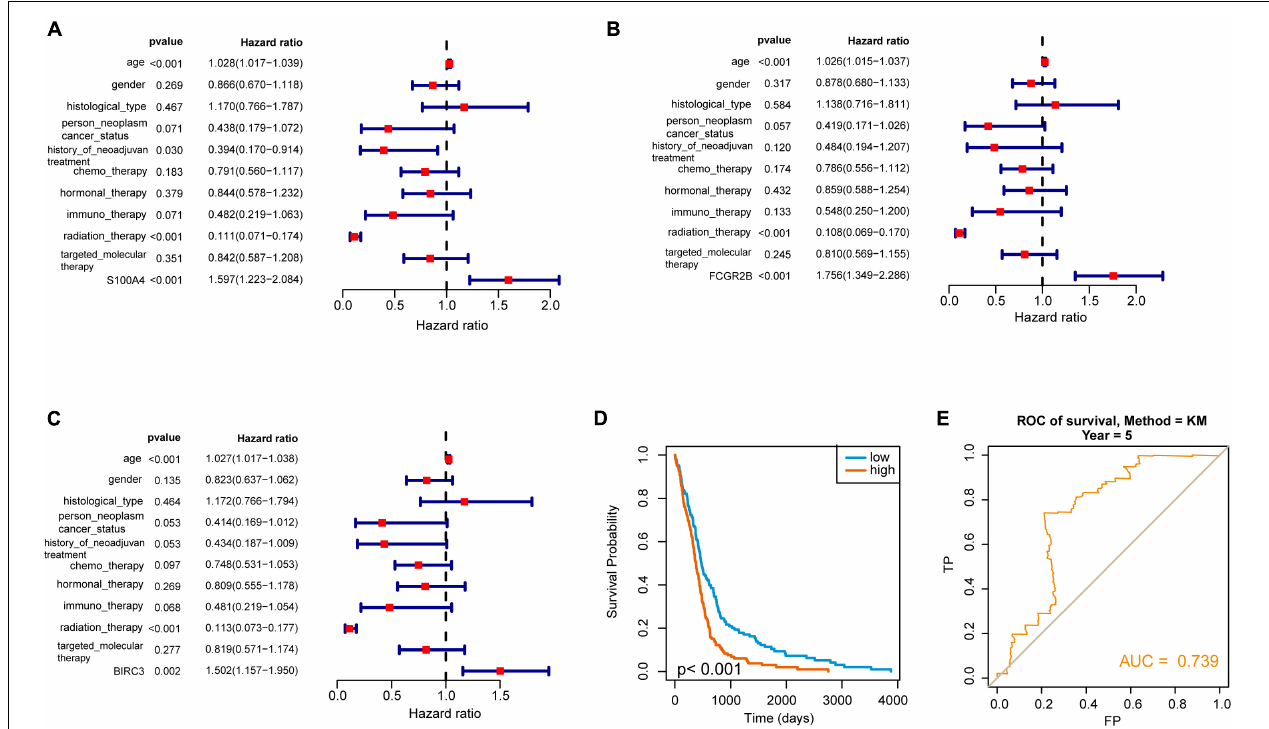
FIGURE 5 | Selection of independent prognostic genes in GBM. (A–C) Forest plot showed the hazard ratio of three hub genes (S100A4, FCGR2B, and BIRC3) and suggested that these genes are independent prognostic factors. (D) The Kaplan–Meier curve showed that the survival model played an excellent prognostic ability in GBM. (E) ROC analysis showed the AUC of the model. It reflected that it is a good prognostic model in GBM.